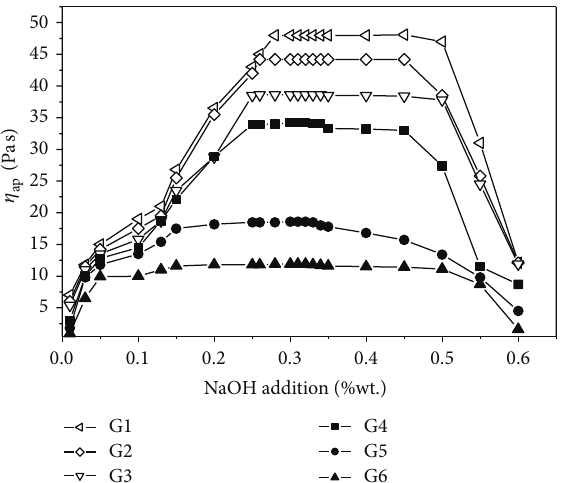
Figure 5: Shear stress versus angular frequency dependence of the hydrogels.